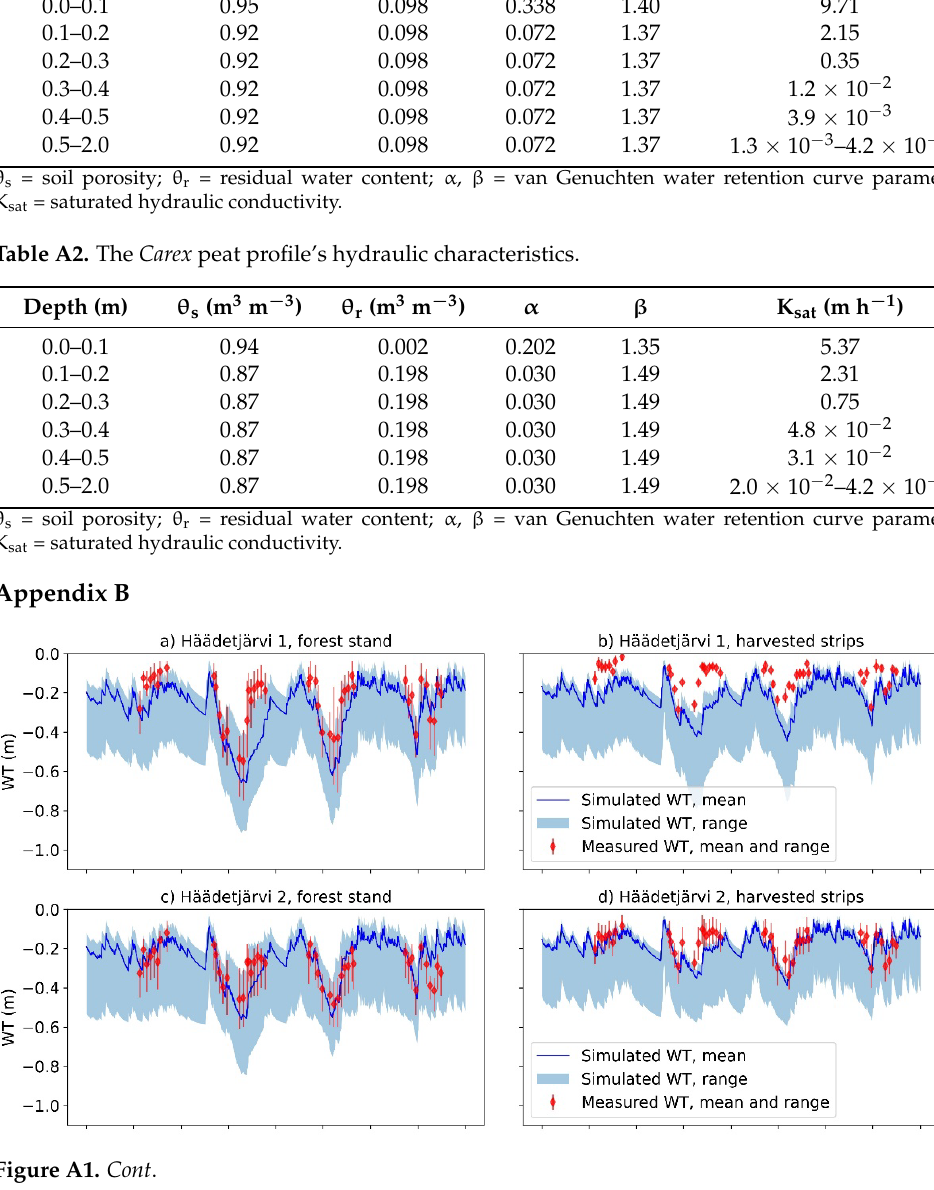
Figure A1. Simulated spatial mean and range of daily WTs in 2017–2020 and measured WTs within unharvested forest stand ( a, c, e, g ) and harvested (treeless) strips ( b, d, f, h ) at the study site. Meas- urement data from tubes located at the edge of forests and harvested strips were omitted. The sim- ulated WTs’ ranges covered the whole forest or harvested area.